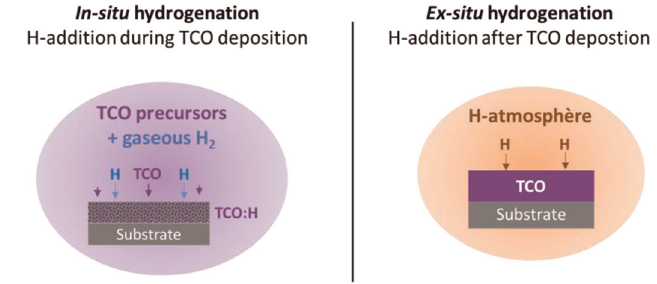
Fig. 2. Schematic view of deposition-free in situ and ex situ hydrogenation of